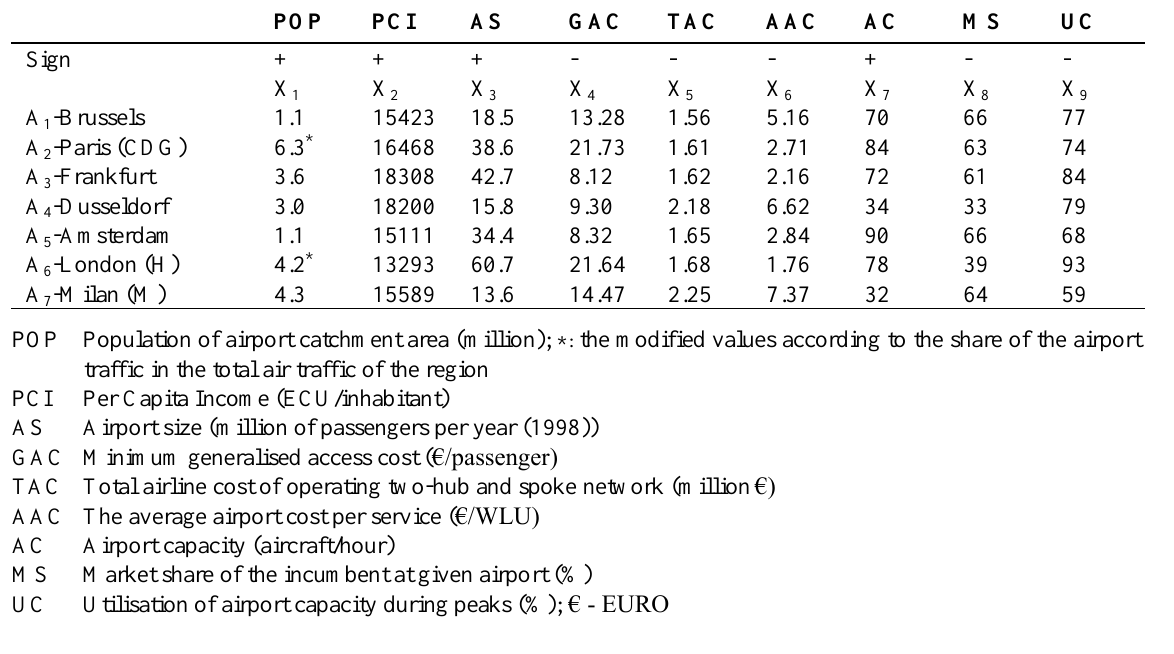
Table 1. Decision Matrix for a given example: seven alternative airports with nine attributes (criteria) Alternative/Airport Attributes (Criteria)